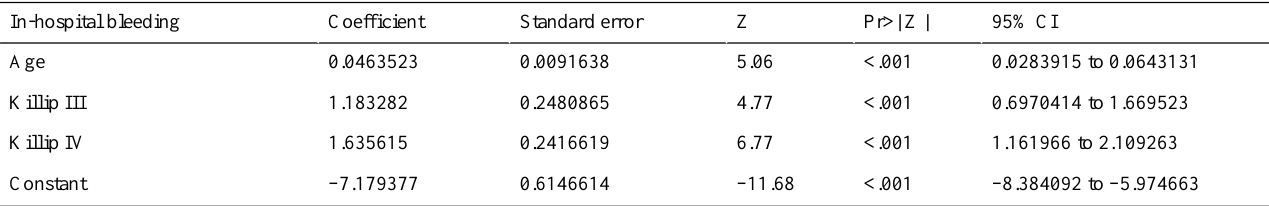
Table 3. Predictor of in-hospital bleeding obtained from multivariable logistic regression models (coefficients) in the development data